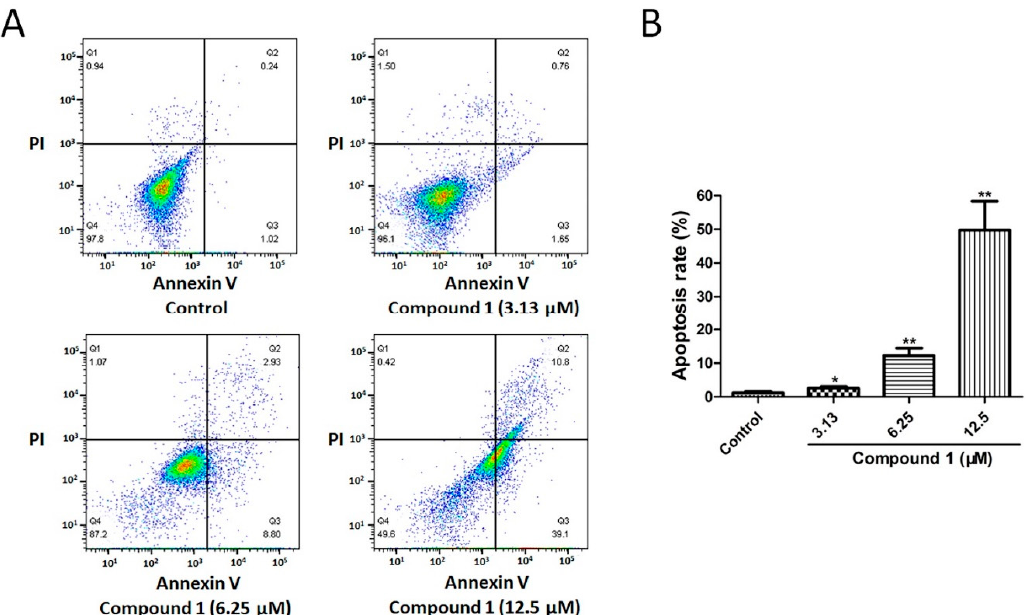
Figure 5. Effect of compound 1 on apoptosis of A549 cells. ( A ) Cell apoptosis in control, compound 1 (3.13 µ M), compound 1 (6.25 µ M), and compound 1 (12.5 µ M) groups was detected via flow cytometry. ( B ) Treatment with 3.13, 6.25, and 12.5 µ M of compound 1 induced apoptosis of A549 cells. Data are shown as the mean ± SD ( n = 3). * p < 0.05 and ** p < 0.01 in comparison with the control group.